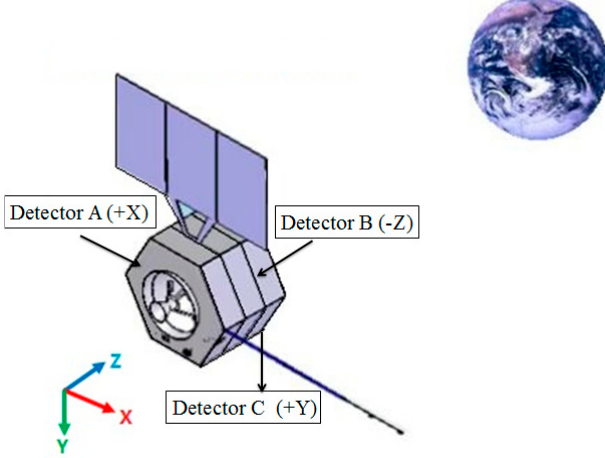
Figure 7. A sketch of the satellite position with reference to Earth and the detection direction of the dose detector. The gate voltage of the PMOS sensor changes with the change in ambient temperature, which affects the accuracy of detection data. Therefore, we should eliminate the change factor of the sensor gate voltage affected by a temperature change. All detectors have undergone a temperature cycling test on ground. We obtained the relationship between the sensor gate voltage and the temperature change without radiation. In this way, we can remove the influence of the PMOS sensor temperature on the space irradiation dose. Next, the change in gate voltage caused by the PMOS sensor only affected by space radiation at each time is calculated, and the cumulative dose of space radiation is finally obtained from the calibration curve. This makes the detection data more accurate. Figures 8–12 are the results of detection data obtained after temperature correction.